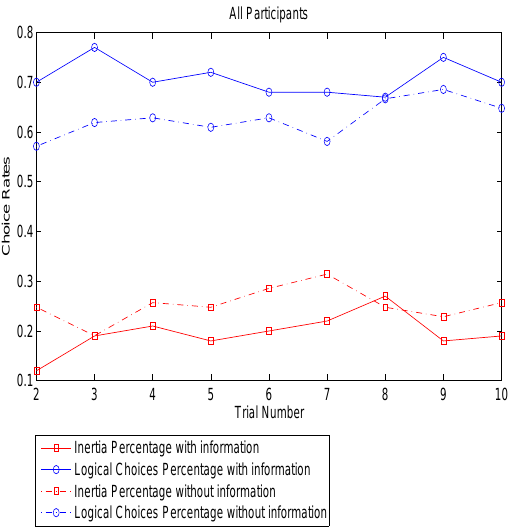
Figure 1. Logical- and inertial- choice rates over